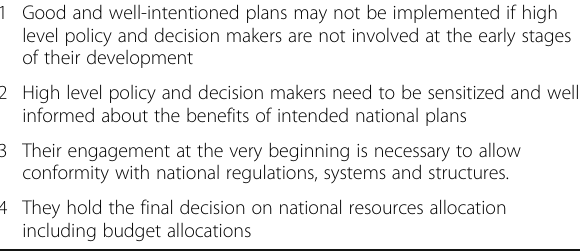
Table 2 The essentials for operationalization of national